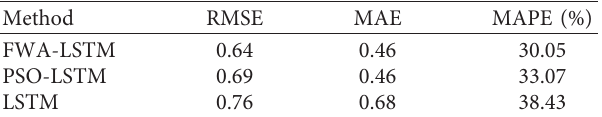
Table 3: The comparison of prediction error index values of the six models. FWA-